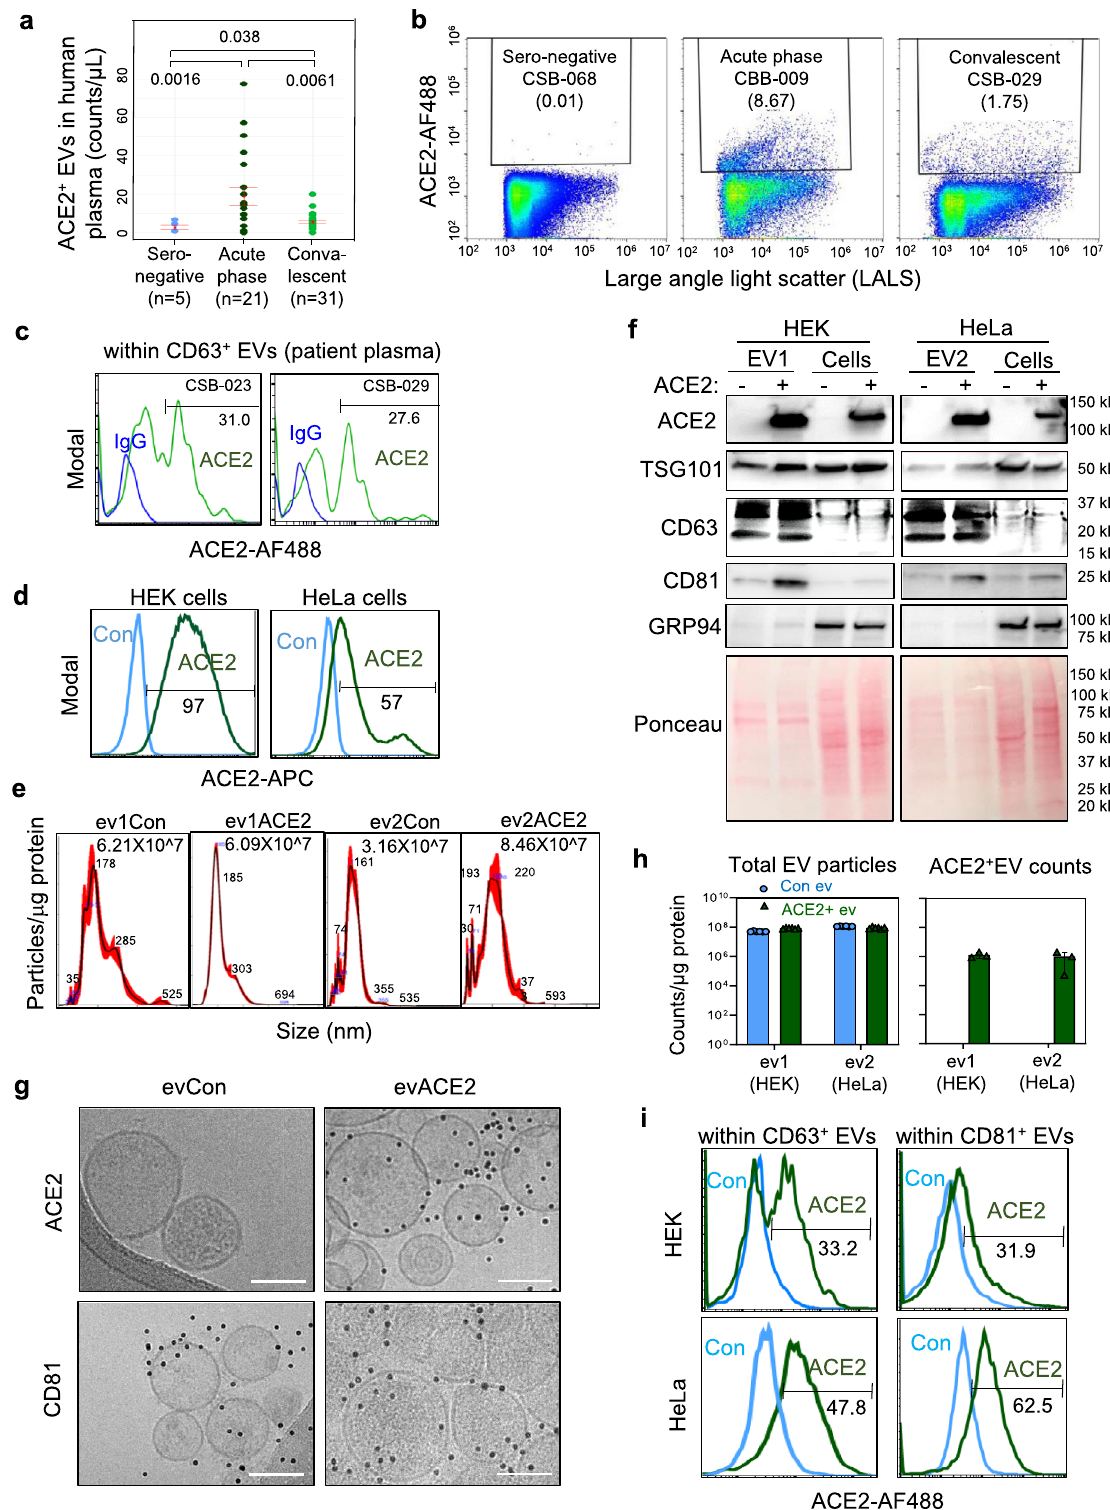
for characterizing ACE2 expression in EVs and determining the binding activity and neutralizing functions of evACE2 to SARS-CoV-2. We generated two sets of human cell lines HEK-293 (HEK) and HeLa, originally negative for ACE2 (ACE2 − control), with stable expression of ACE2 (Fig. 1d). We then utilized a standard ultracentrifugation protocol (100,000 × g × 70 min) to